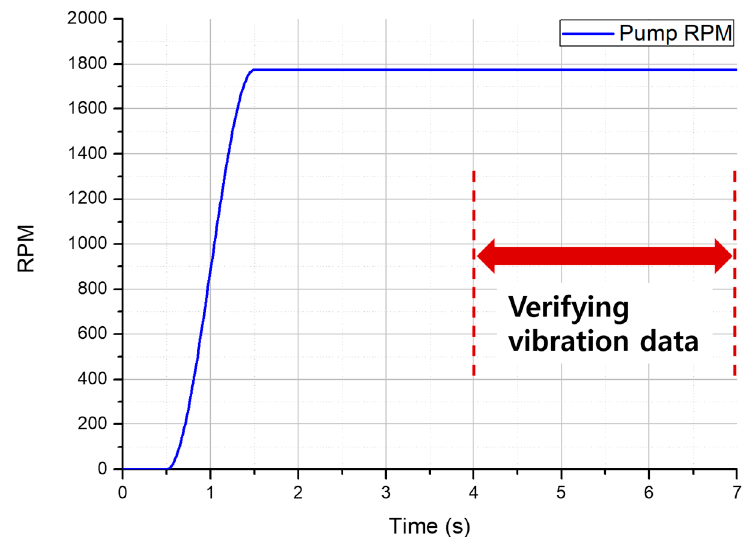
Figure 4. RPM of the pump.